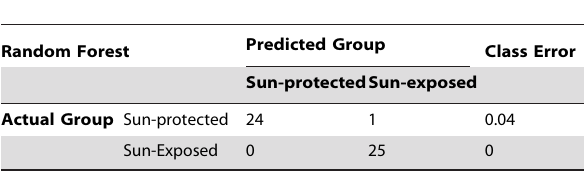
The table represents the classification accuracy with perfect classification in Sun-exposed and very high accuracy in Sun-protected skin samples using the prioritized list of 30 metabolites through Random Forest Classification.